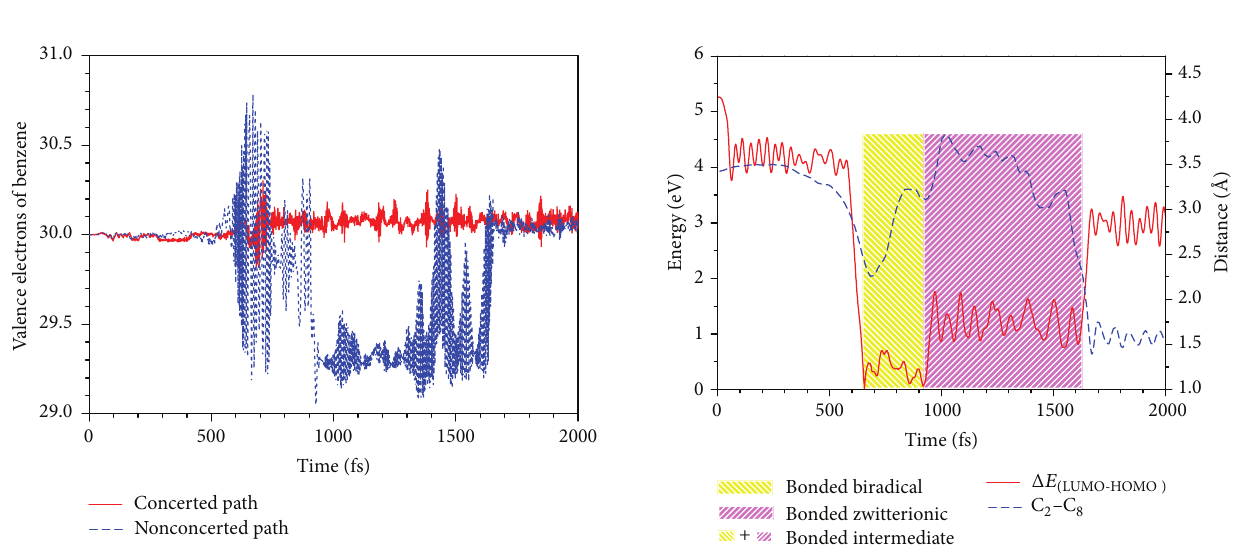
Figure 8: The variations of valence electrons of benzene molecule for each photocycloaddition mode.